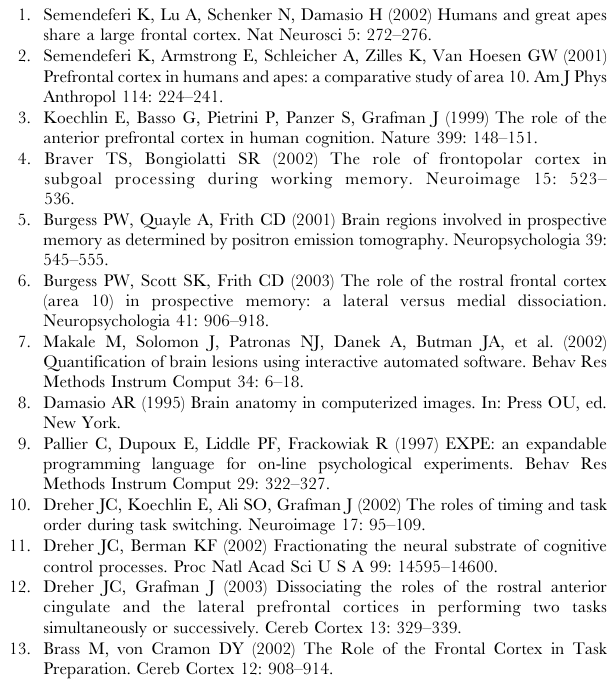
Table S1 Correlation coefficient in the branching condition for each possible n-1 subset of data sample.